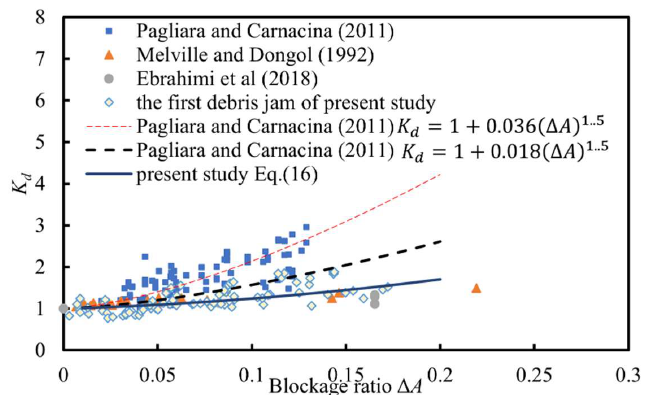
Figure 16. Formula by [7] against experimental data from [7,42,47]; Pagliara and Carnacina [7] K d = 1 + 0.036 ∆ A 1.5 for rectangular and triangular debris jam and K d = 1 + 0.018 ∆ A 1.5 for cylindrical debris jam, blockage ratio here was consistent with the [7].